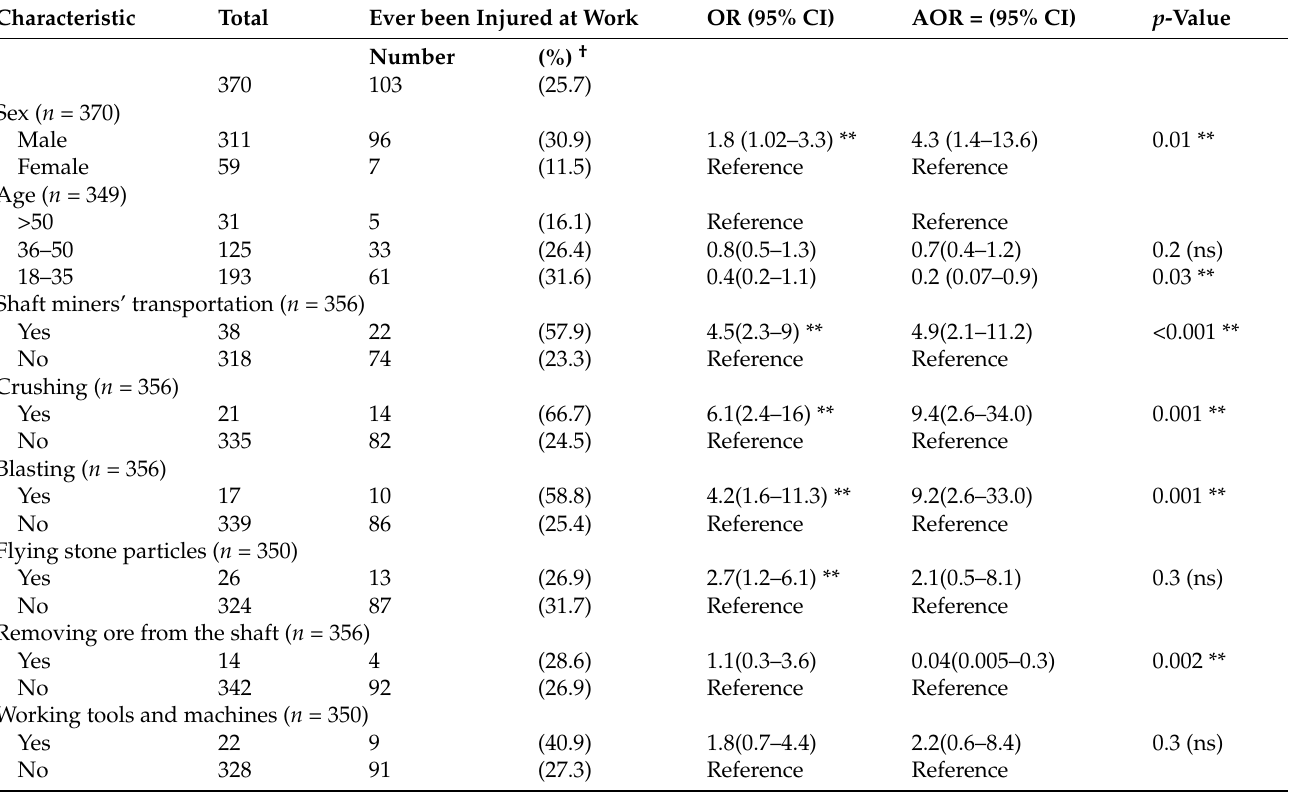
Table 4. Ever-been injured at work and exposure to risk factors: Association between ever being injured at work and exposure to risk factors, reported by miners in Kadoma and Shurugwi in Zimbabwe in the 2020 rainy season.